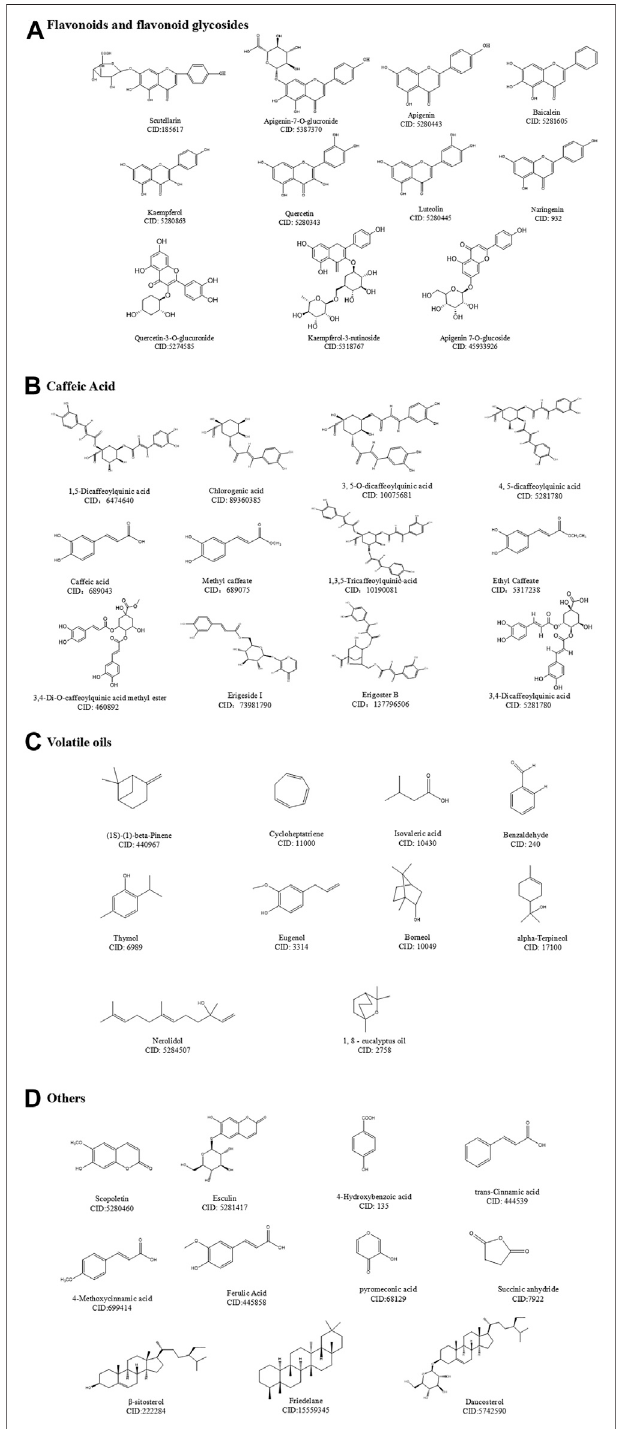
FIGURE 1 | Some typical chemical structures in four types of